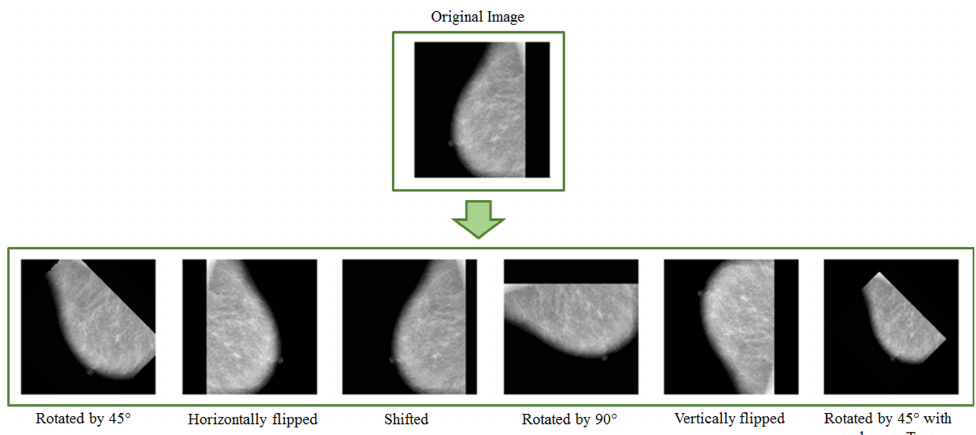
Figure 4. Example of images after applying geometric